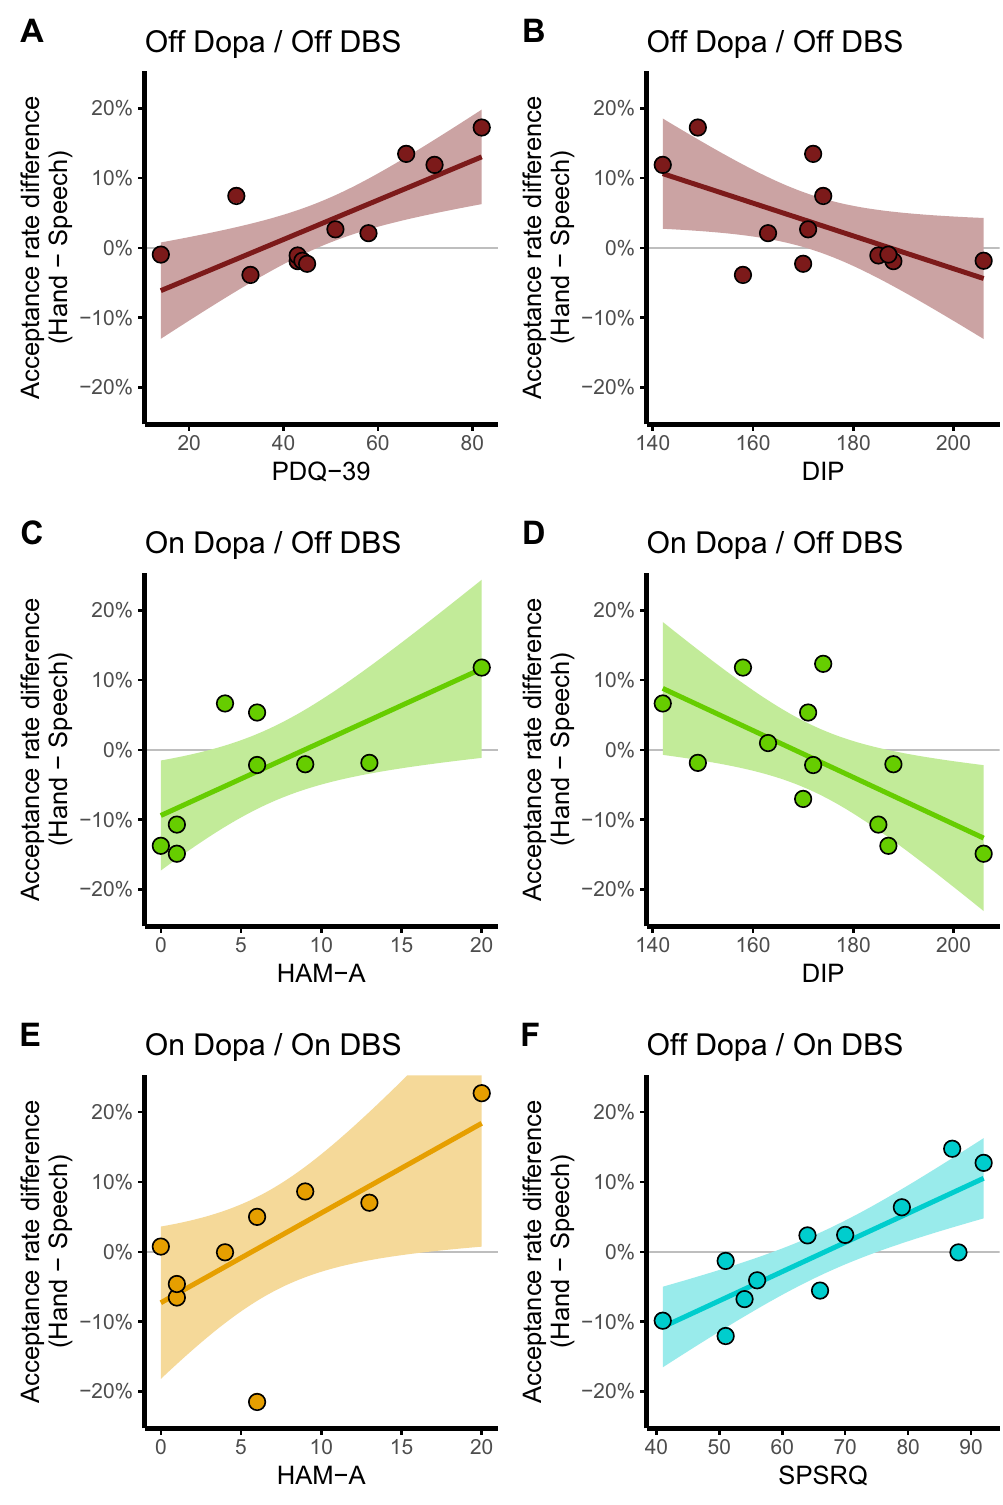
Figure 3. Significant correlations between the difference of acceptance rate between hand and phonation per treatment conditions. A positive value indicates a preference for a hand effort, a negative value indicates a preference for a speech effort, and null value indicates an absence of difference between a hand and a speech effort. DIP: Dysarthria Impact Profile; HAM-A: Hamilton Anxiety Rating Scale; PDQ-39: Parkinson’s Disease Questionnaire–39; SPSRQ: Sensitivity to Punishment and Sensitivity to Reward